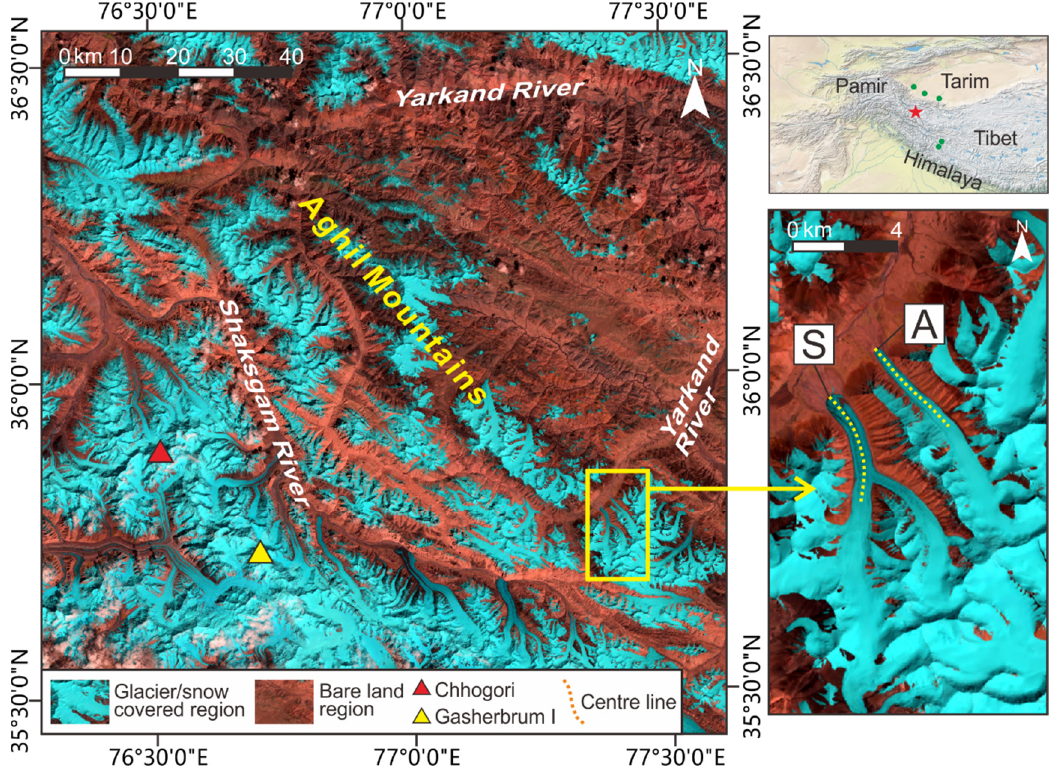
Figure 1. Landsat 8 OLI image (band combination of 6, 5, and 4) of the study area on 8 September 2016. The red star in the topographic map locates the studied glaciers and the green spots represent the locations of meteorological stations in Figure 7.